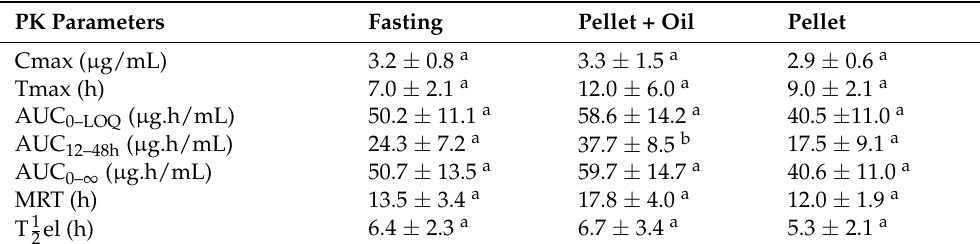
Table 1. Plasma pharmacokinetic variables (expressed as mean ± SD) for the albendazole sulfoxide (ABZSO) obtained after the oral administration of albendazole (ABZ) as a single dose (10 mg/kg, suspension) to pigs fed under different dietary regimens.